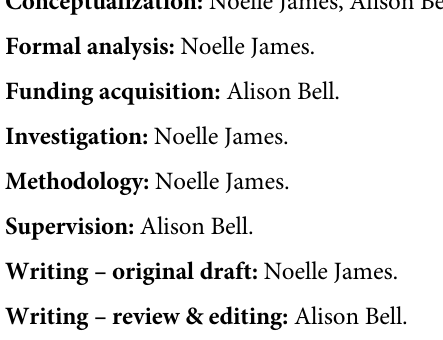
S2 Table. Repeatability of territorial aggression behaviors and respiration rate across the two trials at baseline and after transfection using two-way mixed, single score ICC (type 3,1) for all fish ( N = 54). EYFP is the control, AVP and MAOA are genes of